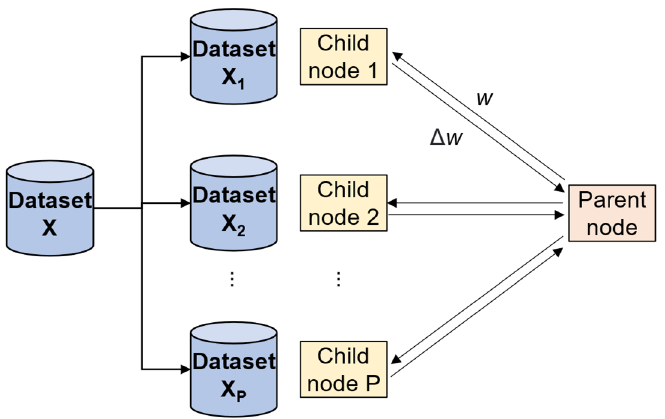
Figure 3. Illustration of a parent–child parallel computing method. The dataset X is divided into P portions and each child node p trains the model using the sub-dataset it was assigned ( X (cid:2926) ).